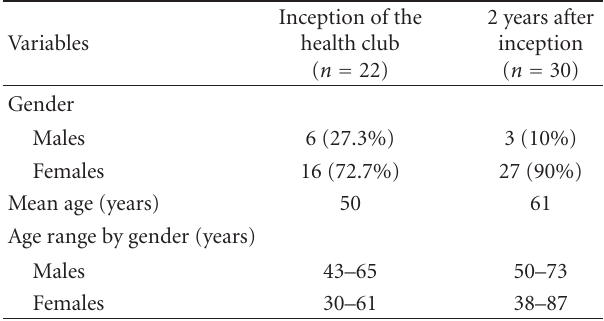
Table 1: General characteristics of club members.